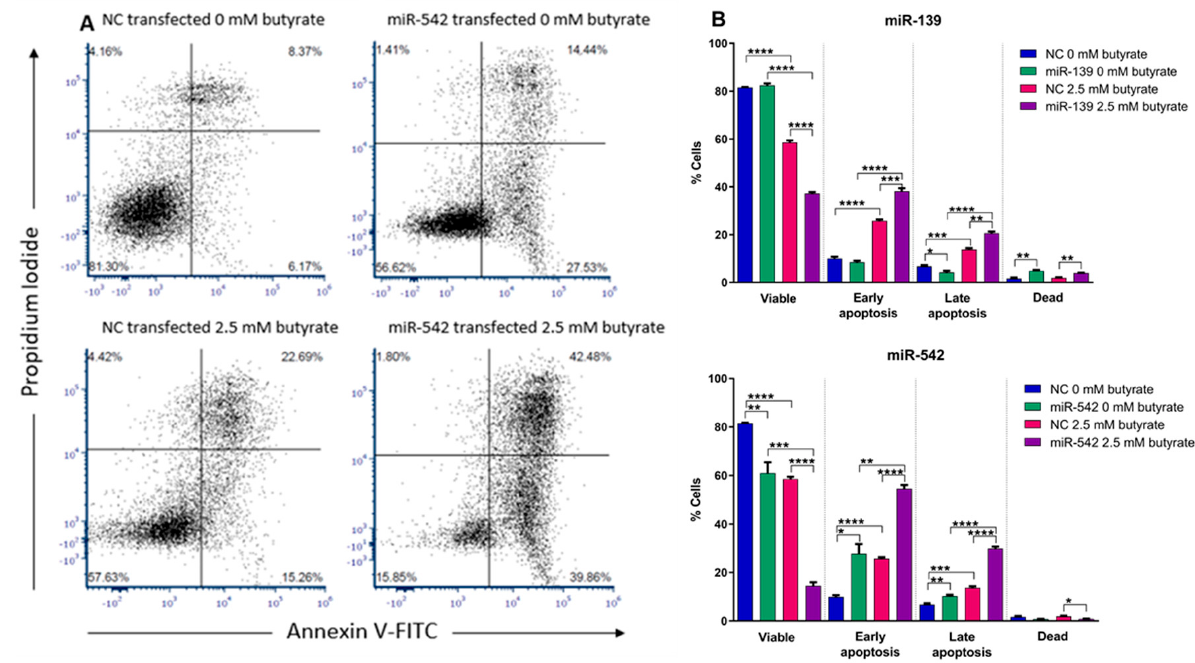
Figure 9. Flow cytometry analysis of apoptosis in miRNA-transfected HCT116 cells after 24 h of butyrate treatment. ( A ) Examples of flow charts depicting the apoptosis analyses of HCT116 cells reverse-transfected with NC or miR-542 mimics for 48 h, followed by 24 h of treatment with 0 mM or 2.5 mM butyrate, over a 72 h post-transfection period. ( B ) Bar charts showing apoptosis analysis of HCT116 cells reverse-transfected with miRNA mimics miR-139 or miR-542 for 48 h, followed by 24 h of treatment with 0 mM or 2.5 mM butyrate, over a 72 h post-transfection period. The mean ± SEM ( n = 3) is shown. Significant results are indicated by * p < 0.05, ** p < 0.01, *** p < 0.001, **** p < 0.0001. NC = negative control mimic.